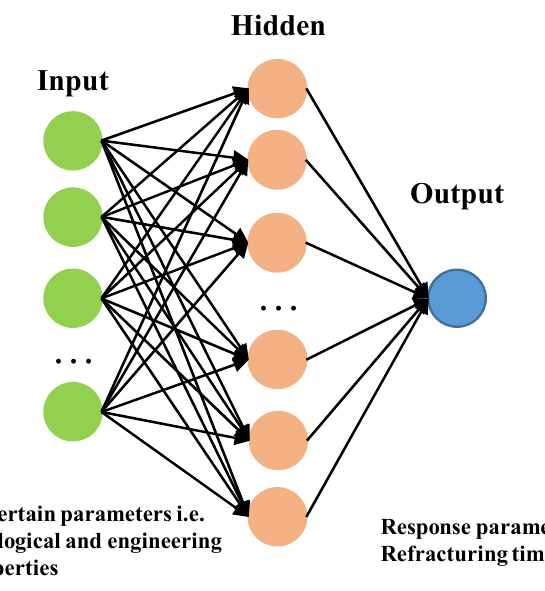
Figure 5. Artificial neural network structure diagram.